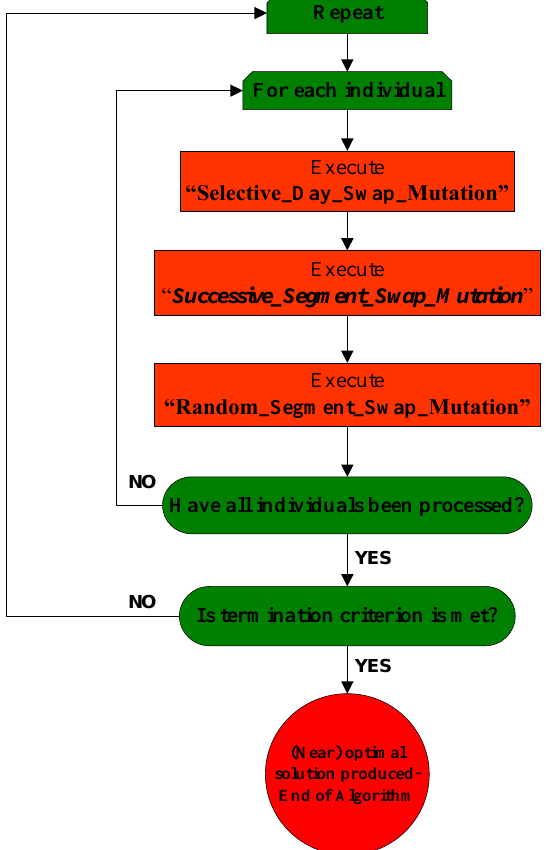
Figure 5. The structure of the second phase of the proposed stochastic variable neighborhood search